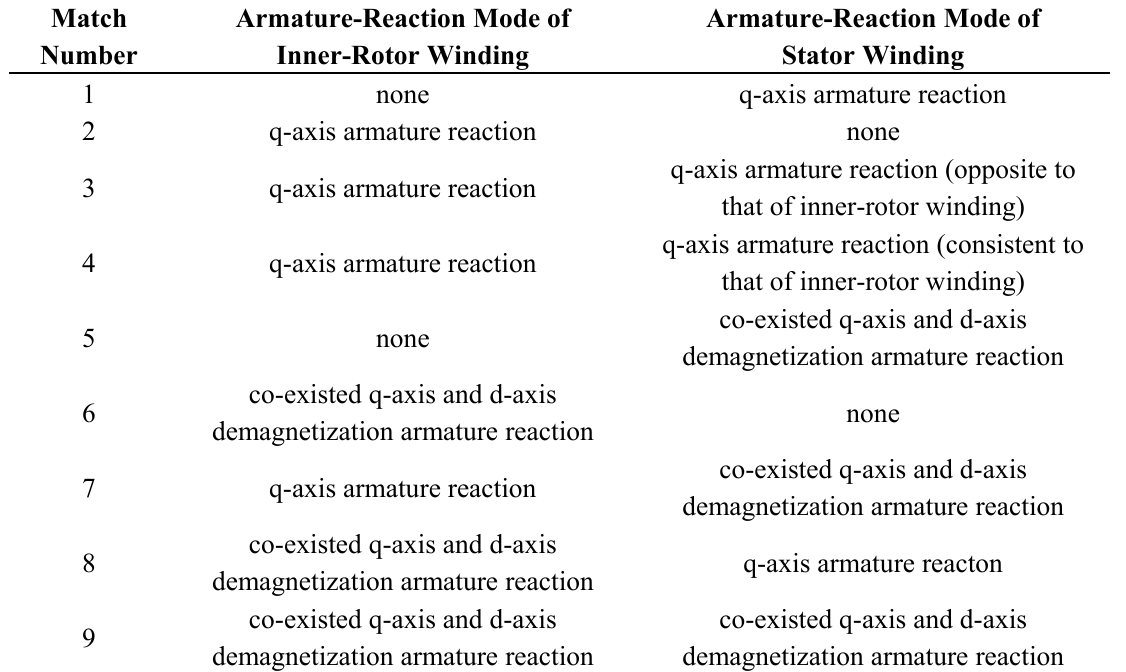
Table 1. Different matches of inner-rotor wingding and stator winding armature-reaction mode.